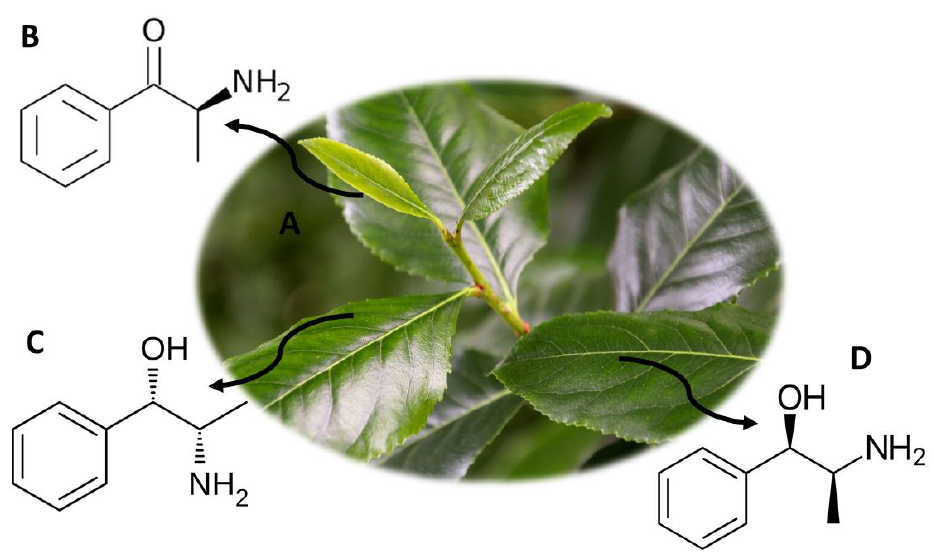
Figure 4. C. edulis ( A ) and the main compounds S-( − )-cathinone ( B ), cathine ([S,S-(+)-norpseudoephedrine]) ( C ) and phenylpropanolamine ( D